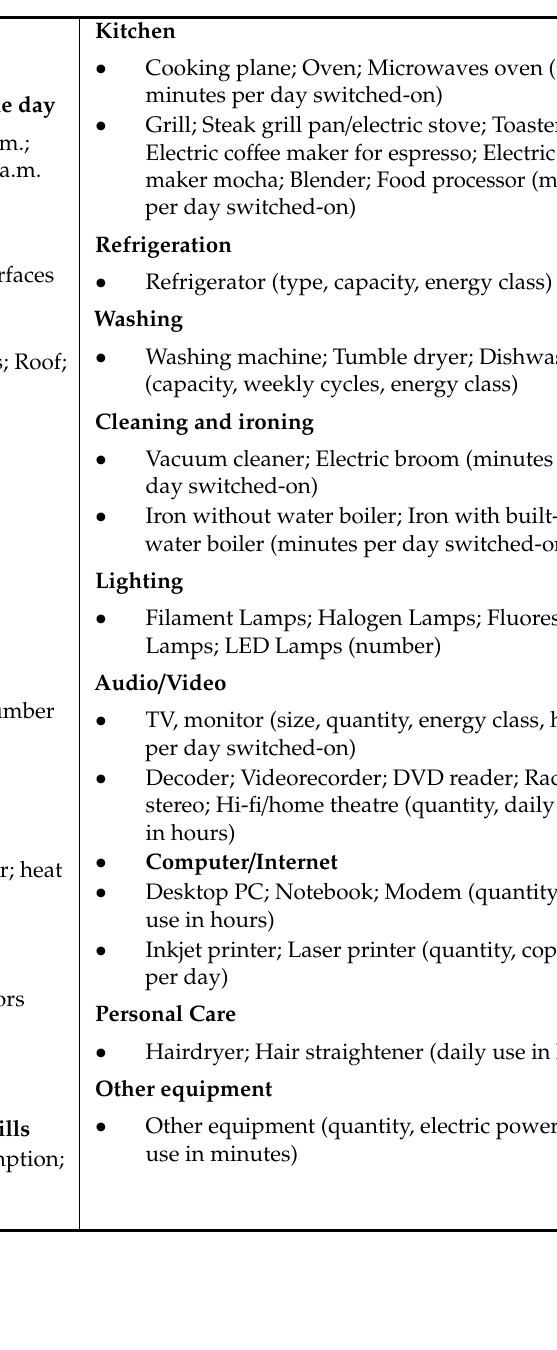
Table A1. Questionnaire structure.